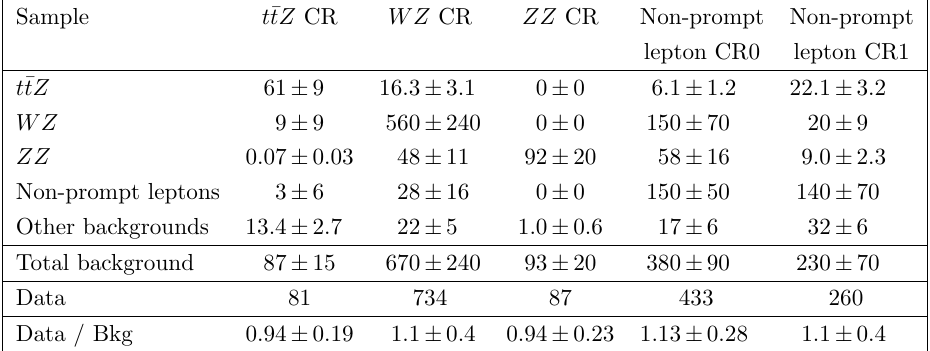
Table 5 . Event yields in the background CRs for all signi(cid:12)cant sources of events before the com- bined (cid:12)t under the background-only hypothesis described in section 8. The uncertainties shown include all of the systematic uncertainties described in section 7. The entry labelled \other back- grounds" includes all remaining backgrounds described in section 3 and in table